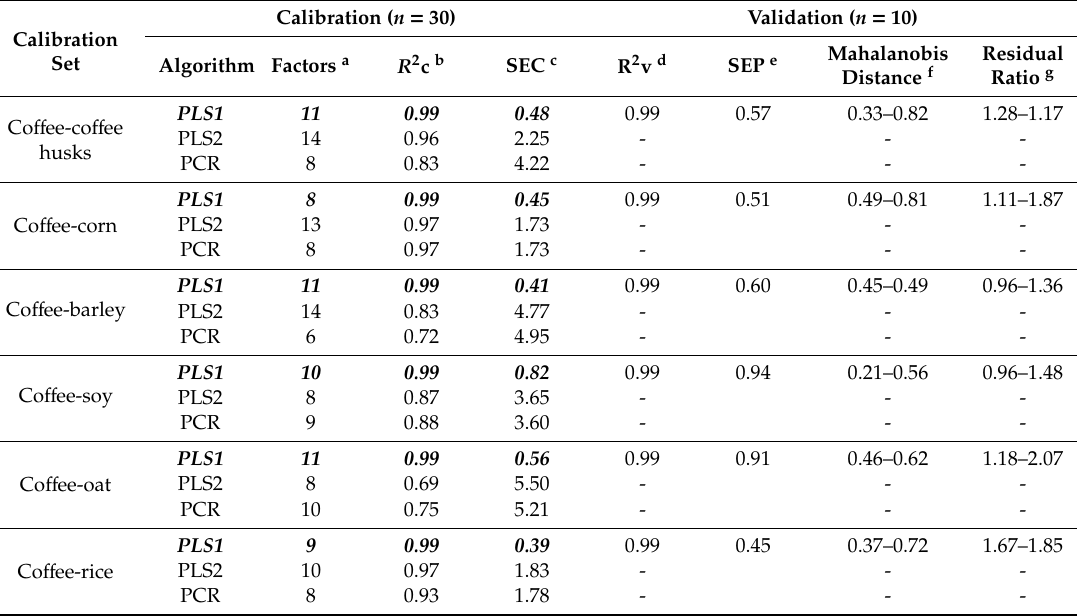
Table 4. Calibration data from chemometric models to predict adulterants of coffee ( Coffea arabica L.). Calibration Set